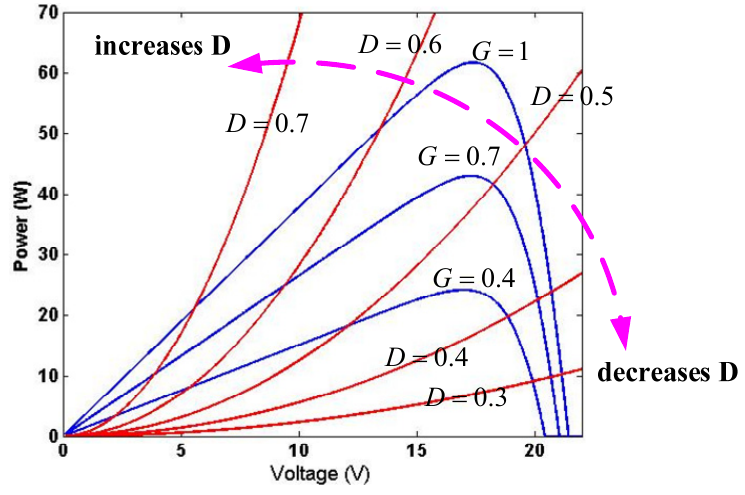
Figure 10. Power characteristics of the PV